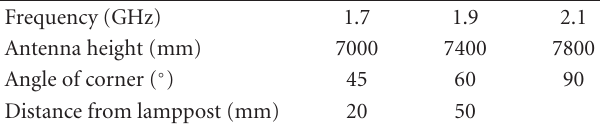
Figure 23: Antenna and lamppost location. Table 3: Parameters of dipole-wall